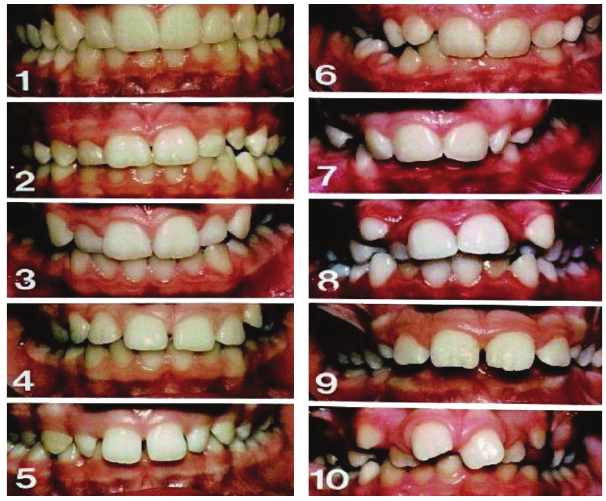
Figure 1: Aesthetic component scale.